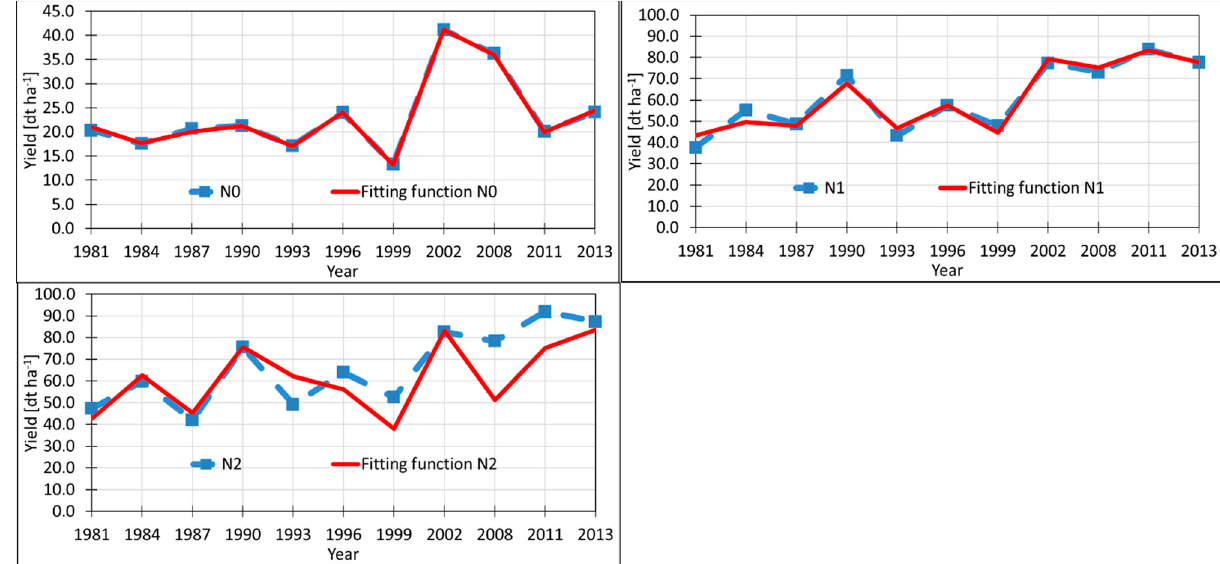
Figure 3. Measured and calculated residuals, with monthly independent variables for different fertilization levels (unfer- tilized plots (N0), moderately fertilized plots (N1), and highly fertilized plots (N2)).